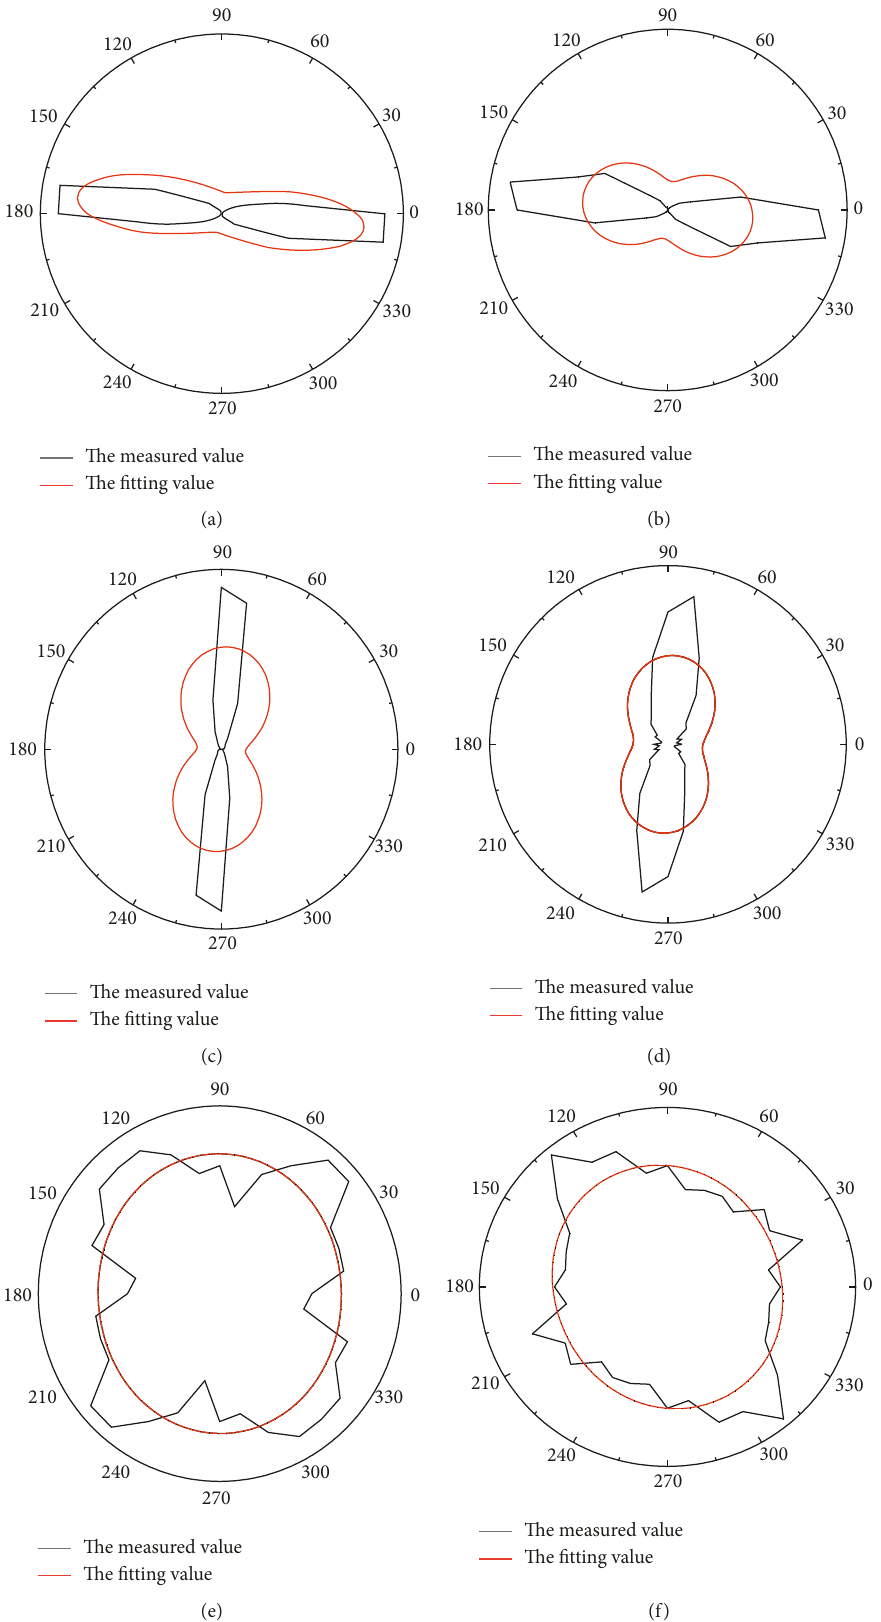
Figure 27: Long axis orientation evolution before and after loading. (a) H-type particles before loading. (b) H-type particles after loading. (c) V-type particles before loading. (d) V-type particles after loading. (e) R-type particles before loading. (f) R-type particles after